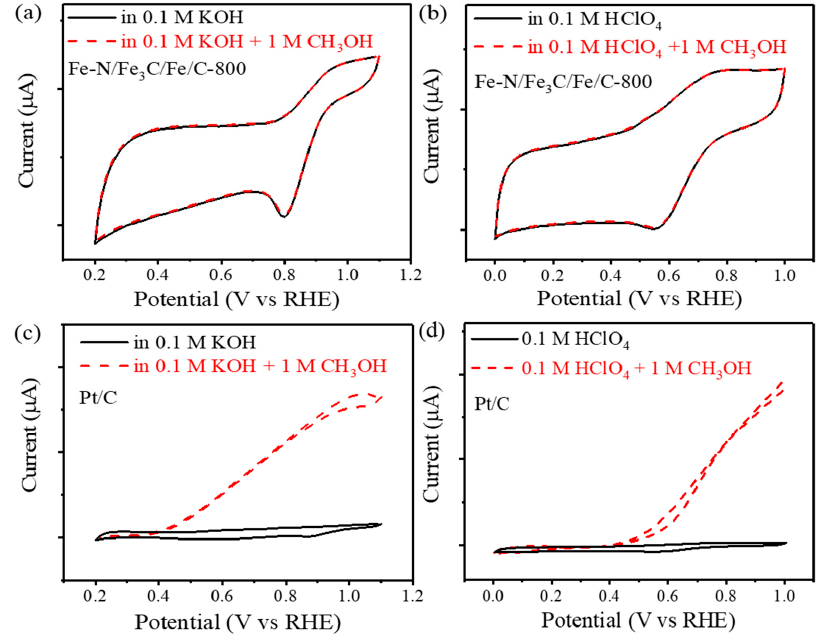
Figure 6. ( a ) Cyclic voltammograms of Fe-N/Fe 3 C/Fe/C-800 before and after adding 1 M CH 3 OH in O 2 -saturated 0.1 M KOH; ( b ) cyclic voltammograms of Fe-N/Fe 3 C/Fe/C-800 before and after adding 1 M CH 3 OH in O 2 -saturated 0.1 M HClO 4 ; ( c ) cyclic voltammograms of Pt/C before and after adding 1 M CH 3 OH in O 2 -saturated 0.1 M KOH; ( d ) cyclic voltammograms of Pt/C before and after adding 1 M CH 3 OH in O 2 -saturated 0.1 M HClO 4